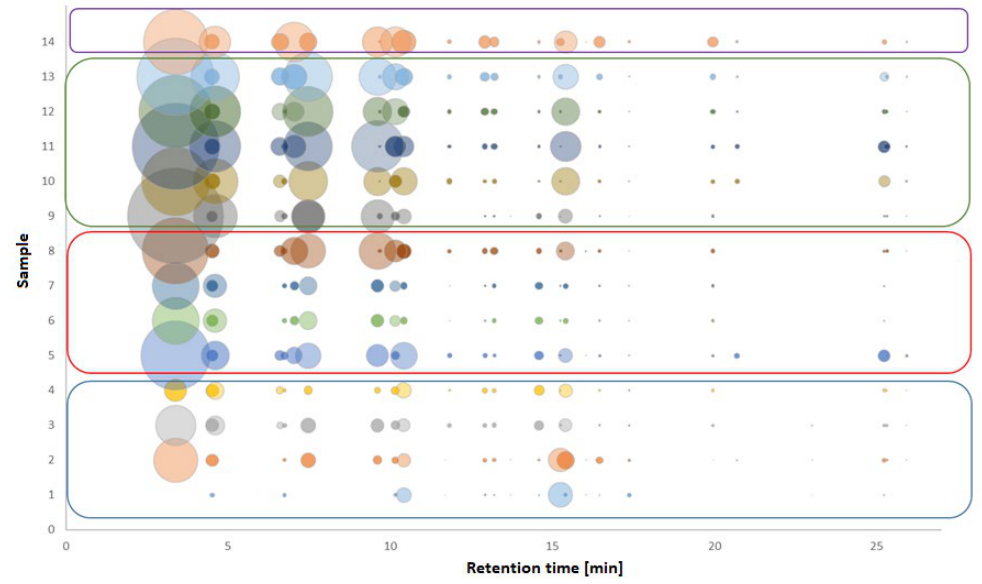
Figure 6. Comparison of the phenolic profile of balsamic vinegar samples obtained by HPLC analysis. Blue box—Greek balsamic vinegar; Red box—BVM; Green box—“premium” BVM; Purple box—TBVM. The first compound is gallic acid. Figure adapted from [96].